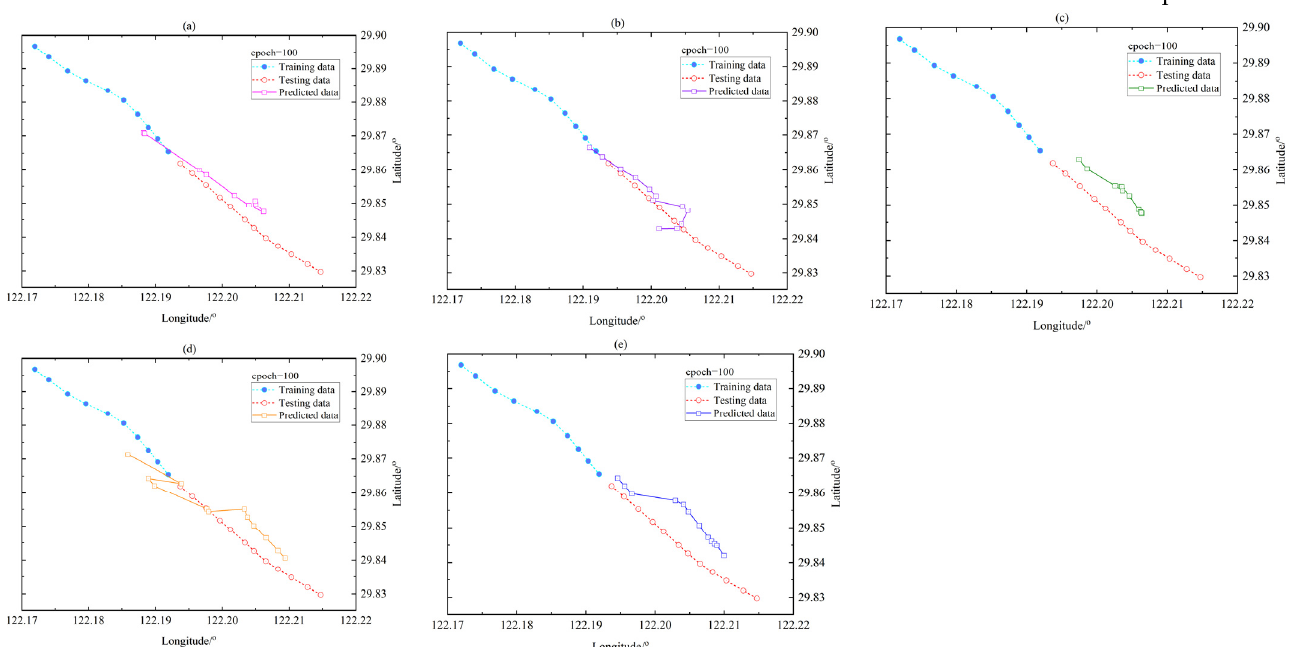
Figure 10. The comparison of the performance after learning 100 epochs of di ff erent methods: ( a )